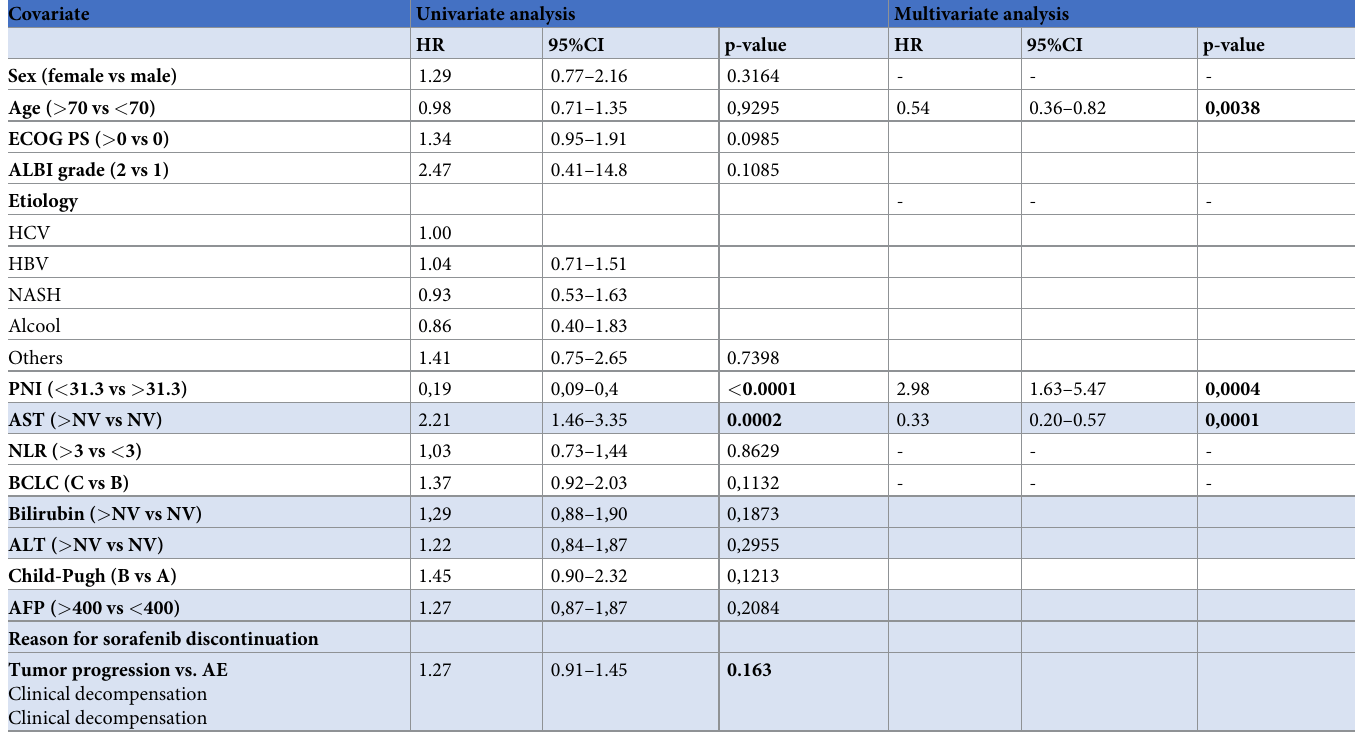
Table 2. Univariate and multivariate analysis in the training cohort.